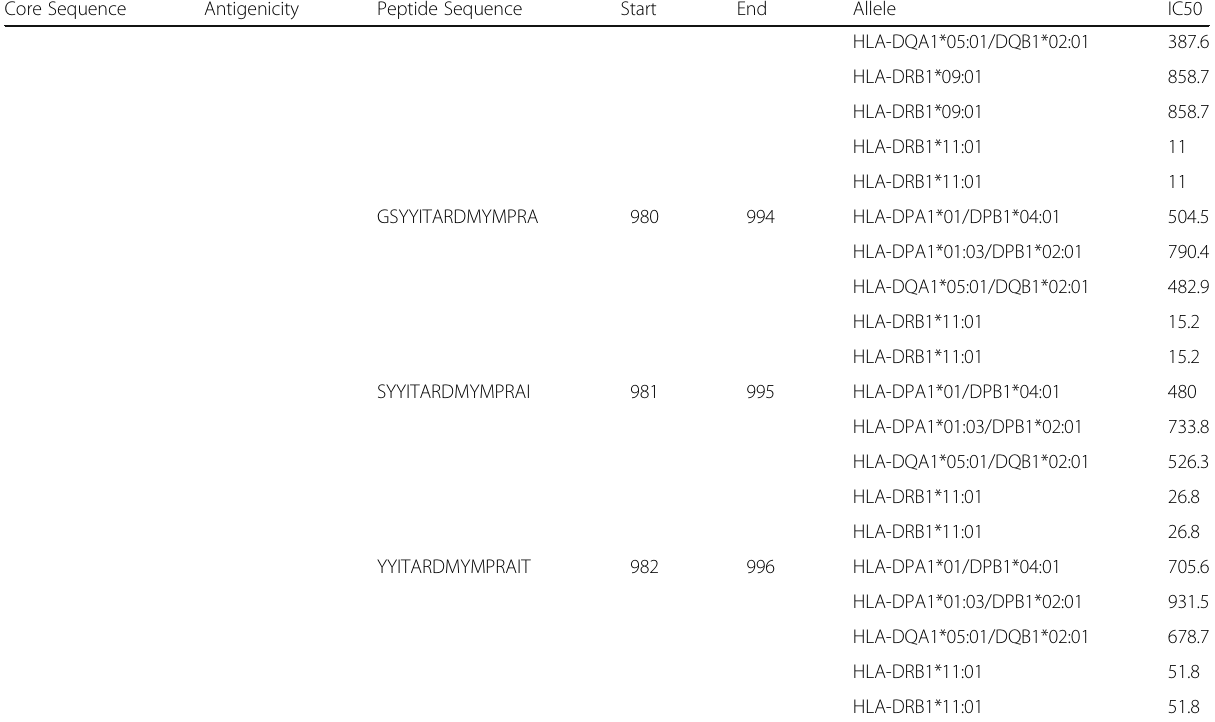
Table 7 Antigenic, non-allergic and non-toxic MHCII epitopes (Continued) Core